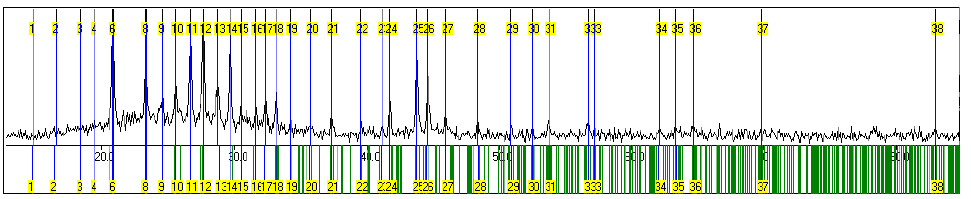
S )(PbS) thin films. 2 3